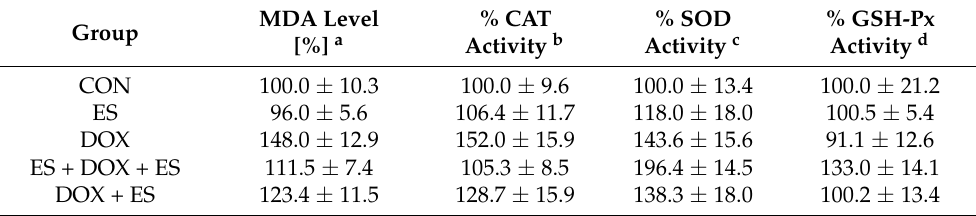
Table 6. Effect of administering spinach extract (ES) on changes in the level of biomarkers of cardiotoxicity induced by DOX in mice model [55]. Group